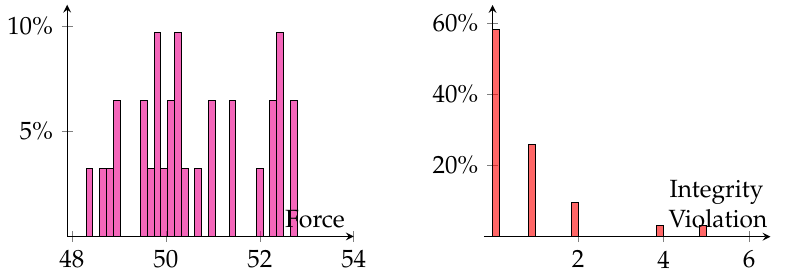
Figure 21. Histograms mono-material solutions: ( left ) values of the computed force; ( right ) solution integrity